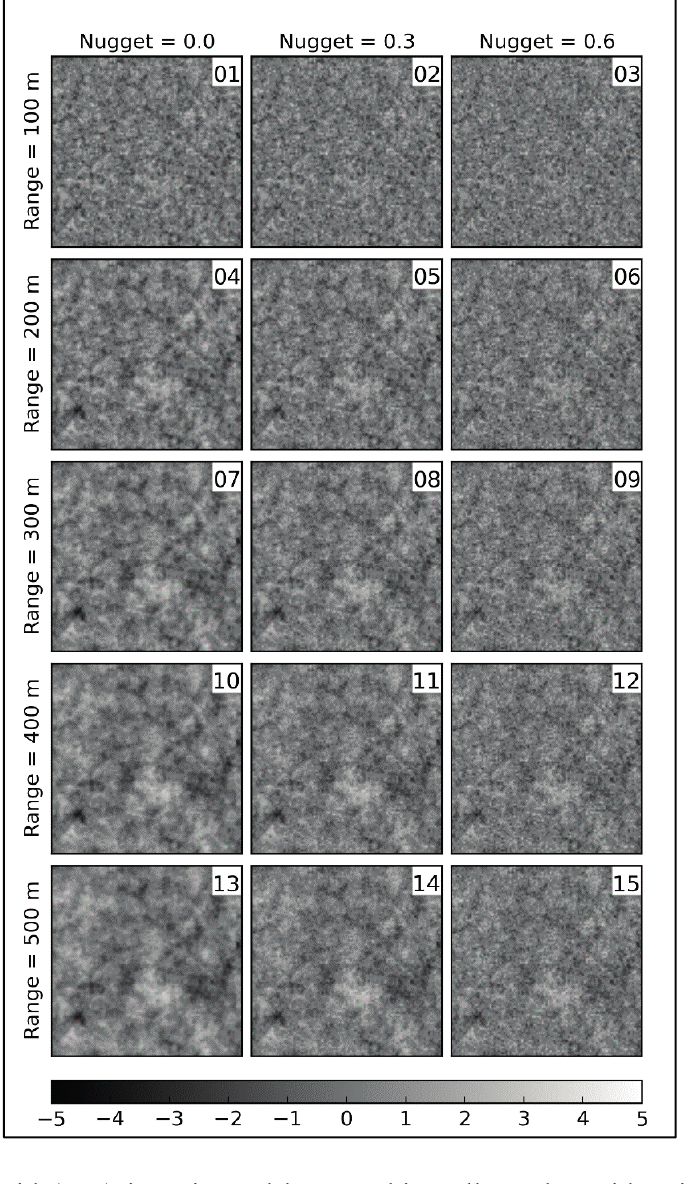
Figure 3. Examples of the simulation fields with 95 × 95 grids produced by the variogram with different parameter